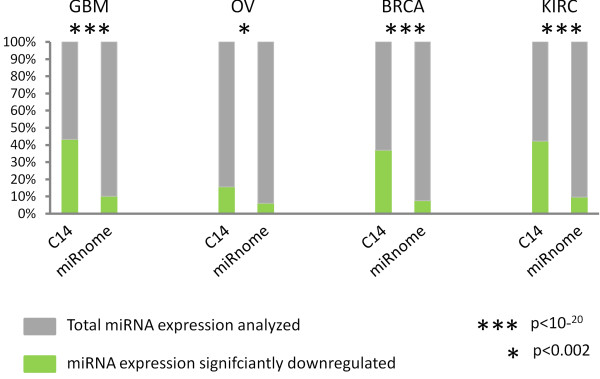
C14 miRNAs are downregulated in other human cancers. For each cancer type the total miRNA expression and the number of miRNAs downregulated are shown both for the C14 cluster and the entire miRnome. On the Y-axis the different numbers has been normalized to 100%. The fraction marked in green demarcates the proportion of miRNAs downregulated (significant after Bonferroni correction) against all miRNAs tested (in grey). As depicted in the figure for all the cancer types (albeit less for OV) the proportion of downregulated miRNAs from C14 is much higher than that from the miRnome (green bars). The detailed data and analysis is in Additional file 6. GBM, Gliobalstoma Multiforme; OV, ovarian serous cystadenocarcinoma; BRCA, Breast invasive carcinoma and KIRC, Kidney renal clear cell carcinoma.